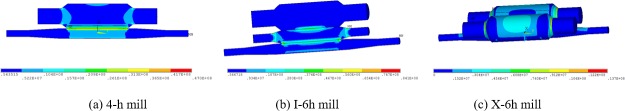
Von Mises stress field of the different roll layouts.